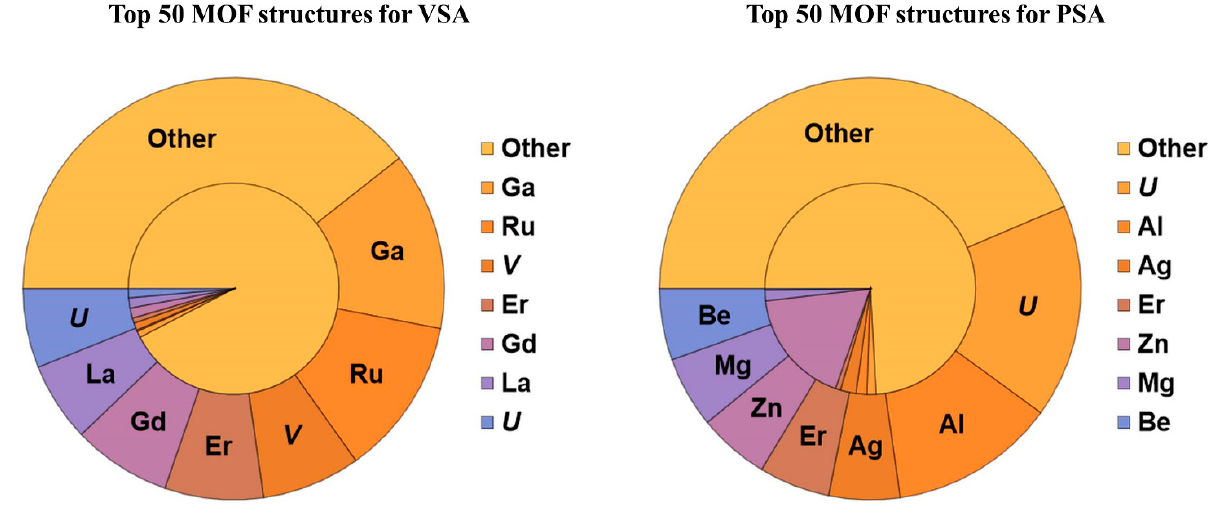
Figure 4. Chemical composition distribution of MOF structures by metal type. The outer pie chart corresponds to the Top 50 best MOFs, the inner one corresponds to all MOFs considered in this study.